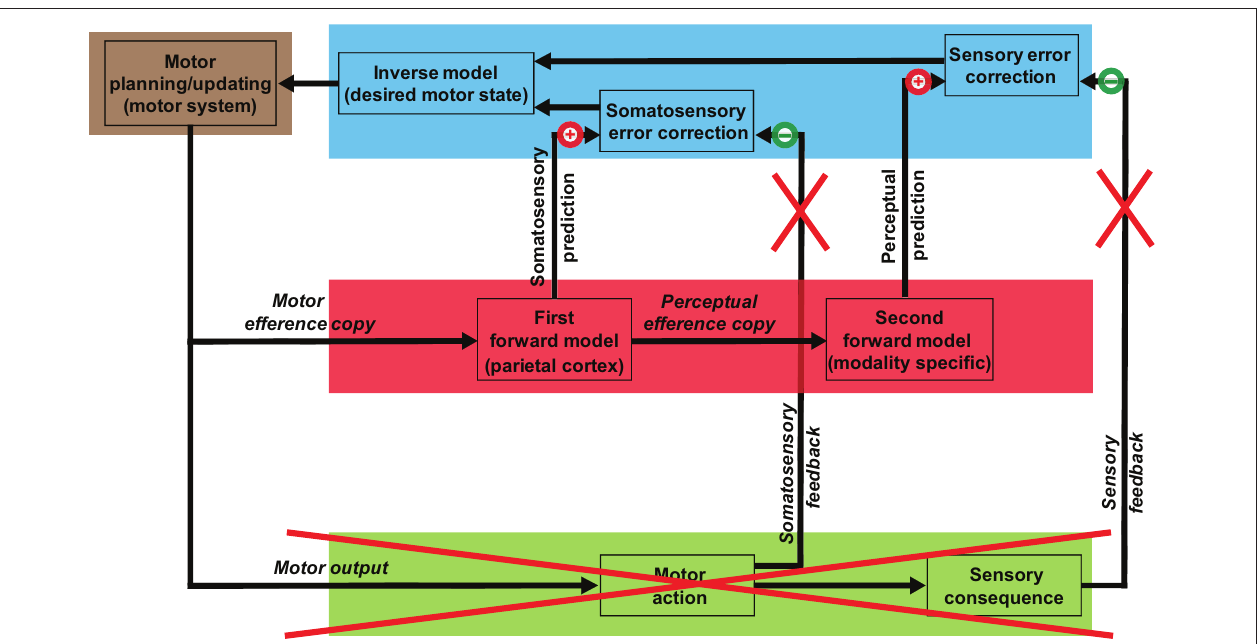
FIGURE 1 | Model of speech processing and its implication for mental imagery of speech. The internal simulation and estimation model proposed as a second route to generate mental images. The motor systems that mediate action preparation carry out the same functions in mental imagery of speech, but only perform motor simulation, in the sense that the planned motor commands are truncated along the path to primary motor cortex and are not executed (the red cross over external outputs). A copy of such planned motor commands (motor efference copy) is processed internally and is used to estimate the associated